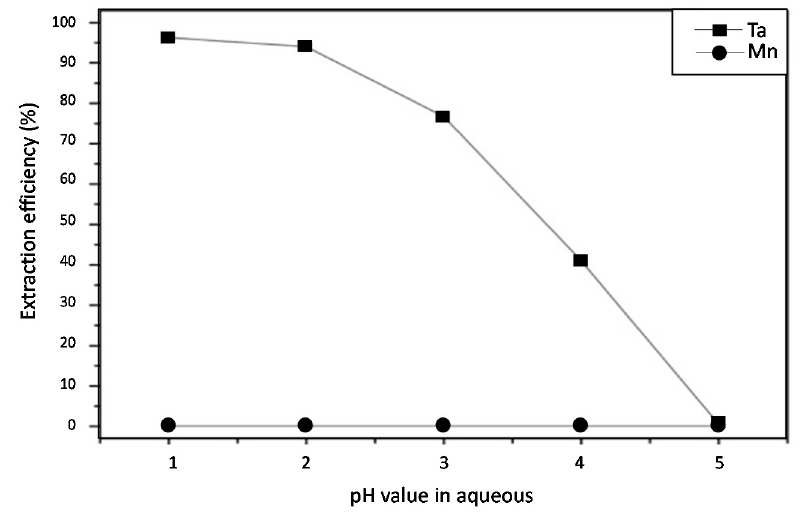
Figure 10. Influence of pH-value 1–5 on the extraction efficiency of Ta using Alamine 336 for solvent extraction, based on [74].